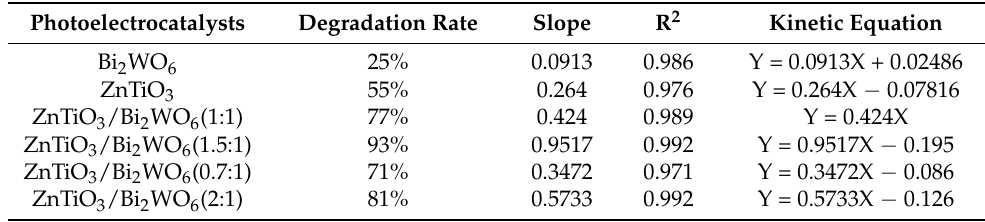
Table 2. Kinetic parameters of the prepared catalyst.